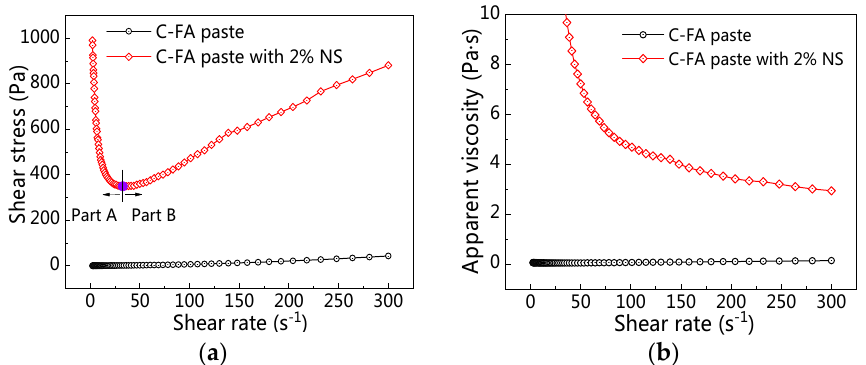
Figure 5. Rheological curves (at resting time 120 min): ( a ) shear stress vs. shear rate; ( b ) apparent viscosity vs . shear rate.